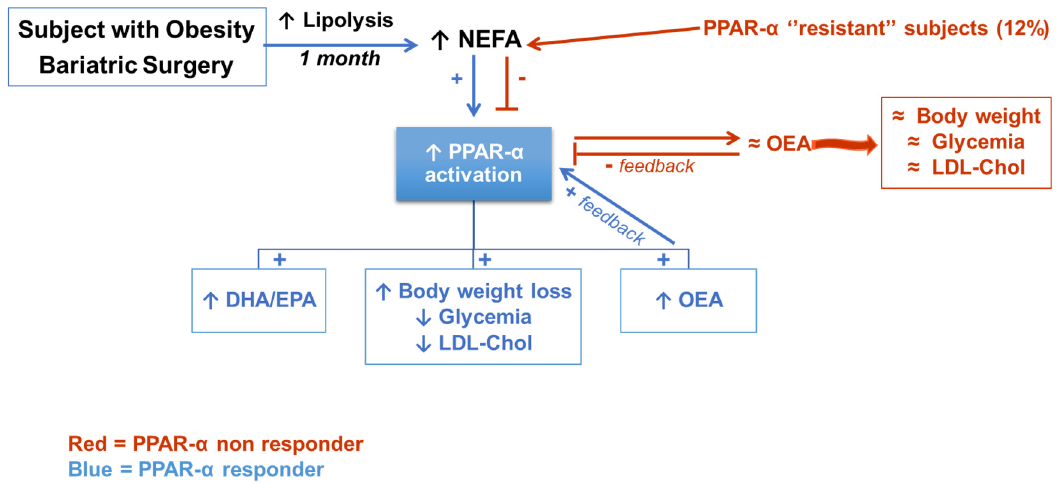
Figure 6. The increased NEFA released from adipose tissue may activate PPAR- α which induces PUFA metabolism, FA β -oxidation and increased circulating OEA levels further enhance PPAR- α activation and hence induce body weight loss and improved glucose and lipid metabolism. In red the putative mechanism which may explain why four subjects (12%) did not respond in the same way to circulating NEFA, leading us to hypothesize a ’’resistance’’ to PPAR- α activation. Red, PPAR- α non responder subjects; Blue, PPAR- α responder subjects; ↑ , increase; ↓ , decrease; +, positive regulation; -, negative regulation; ≈ , unchanged.